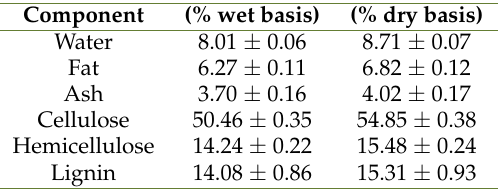
Table 1. Chemical components of the untreated oil palm empty fruit bunch (OPEFB).